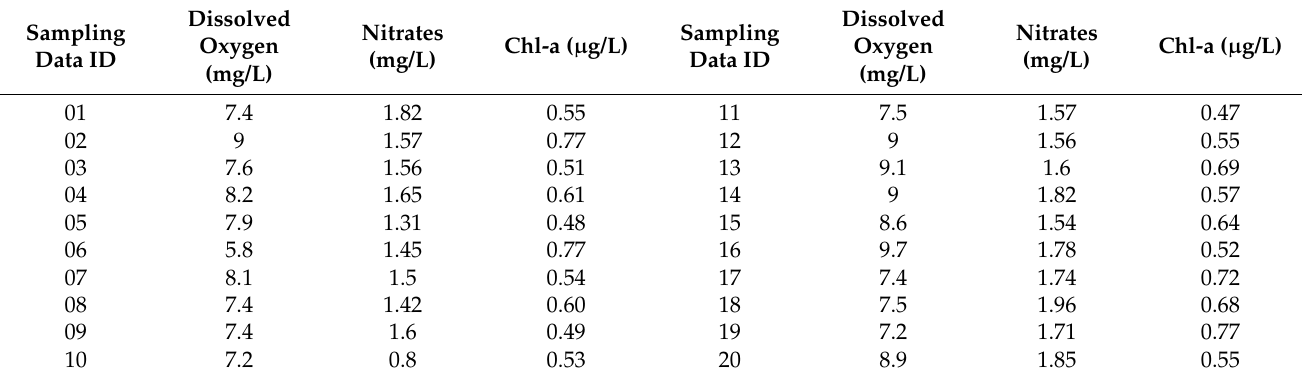
Table 1. On-ground data sample